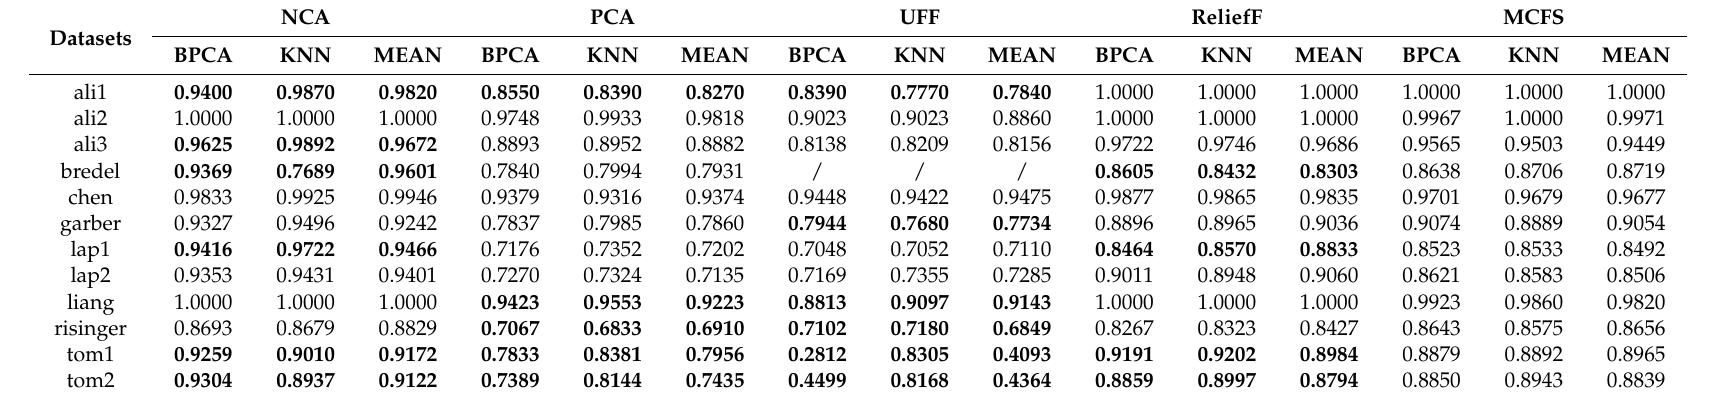
Table 4. Performance comparison of FS algorithms under the three MV imputation